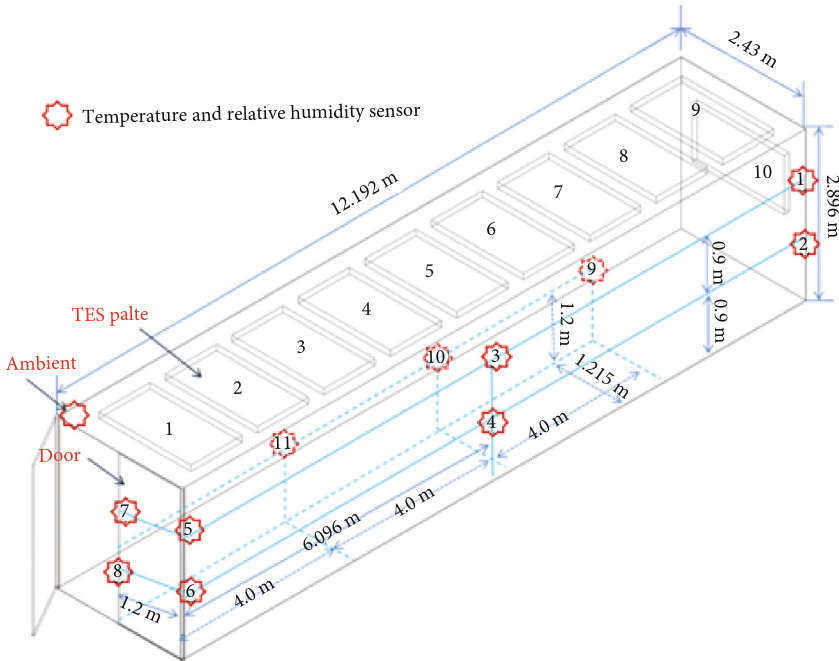
Figure 2: Distributions of TES plates and the sensors of the shipping container.